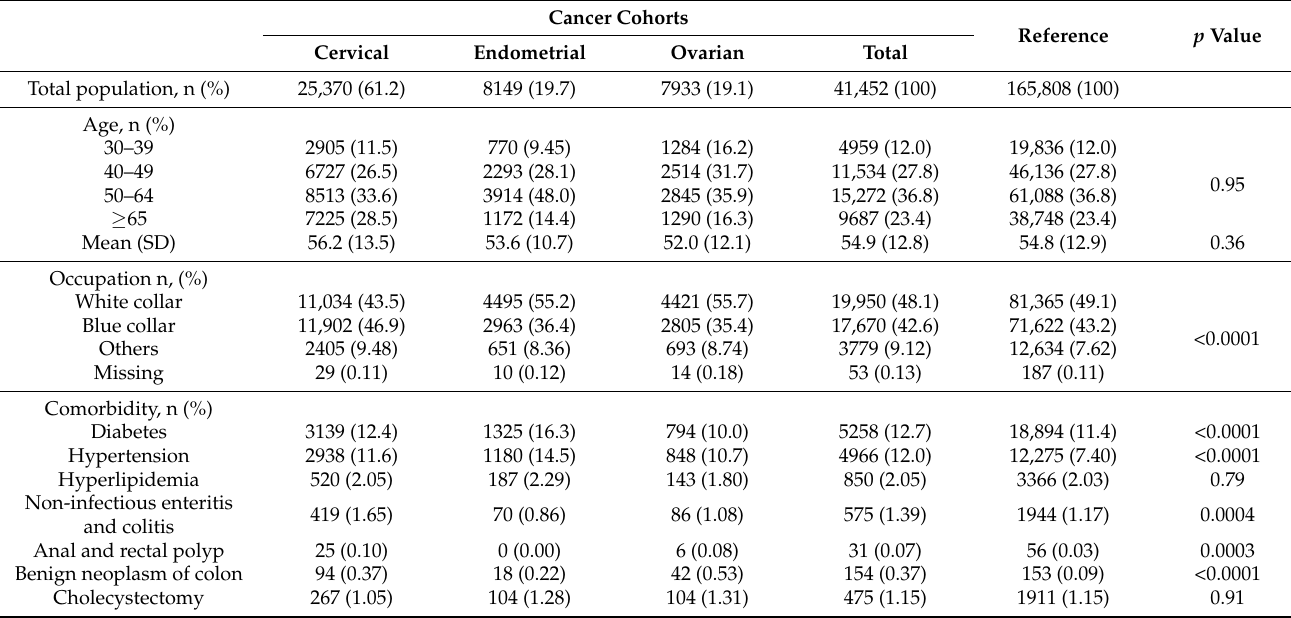
Table 1. Distributions of gender, age, and comorbidity among gynecologic cancer cohorts and reference cohort identified from 1998 to